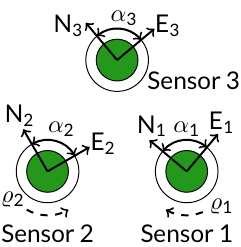
Fig. 2. Schematic view illustrating the misalignment between three sensors’ horizontal components and the rotation performed about their z axes in order to align two sensors with the third ( % i ).